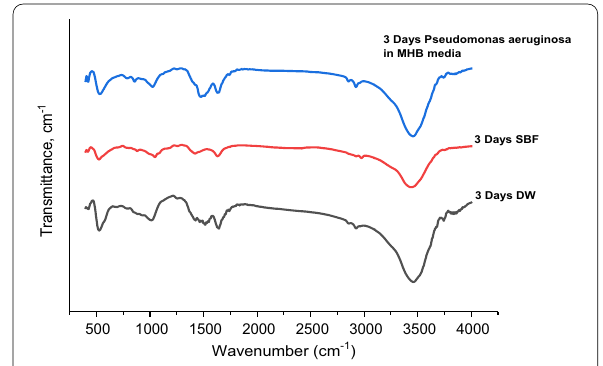
Fig. 9 FTIR spectral bands of 3-day sample cured in distilled water (DW) simulated body fluid (SBF) and Pseudomonas aeruginosa in Mueller Hinton Broth (MHB media)